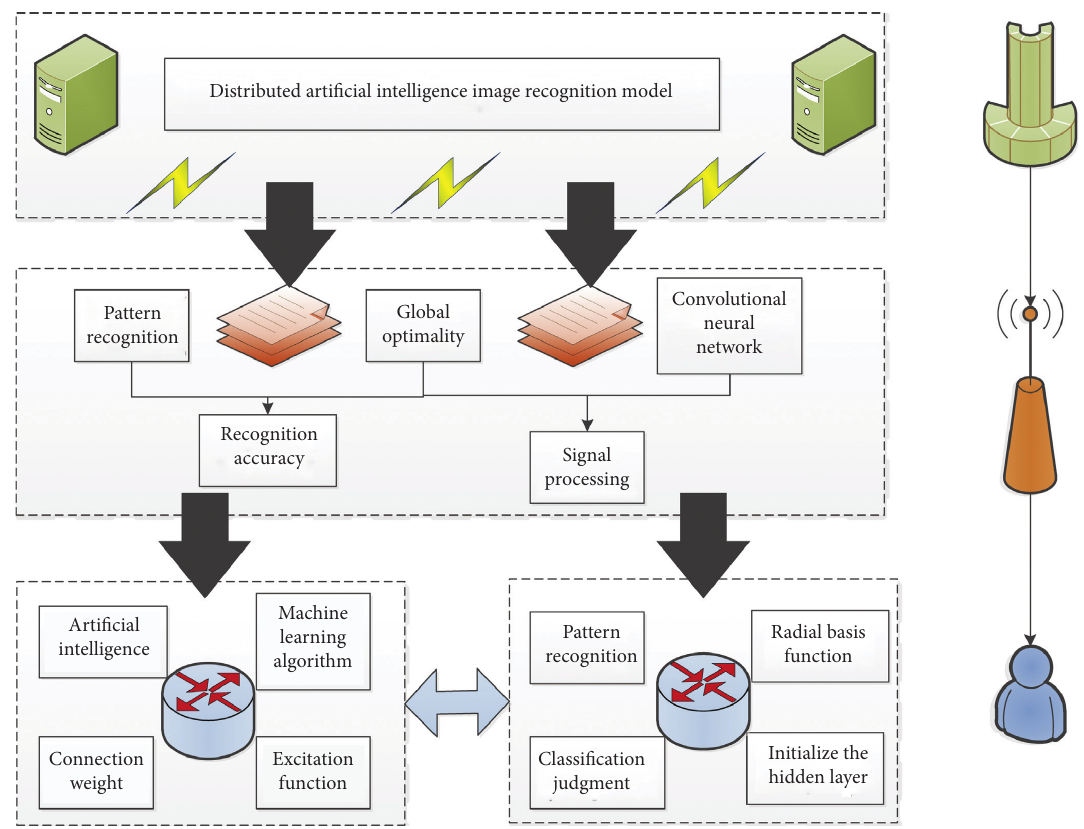
Figure 3: Distributed artificial intelligence image recognition model